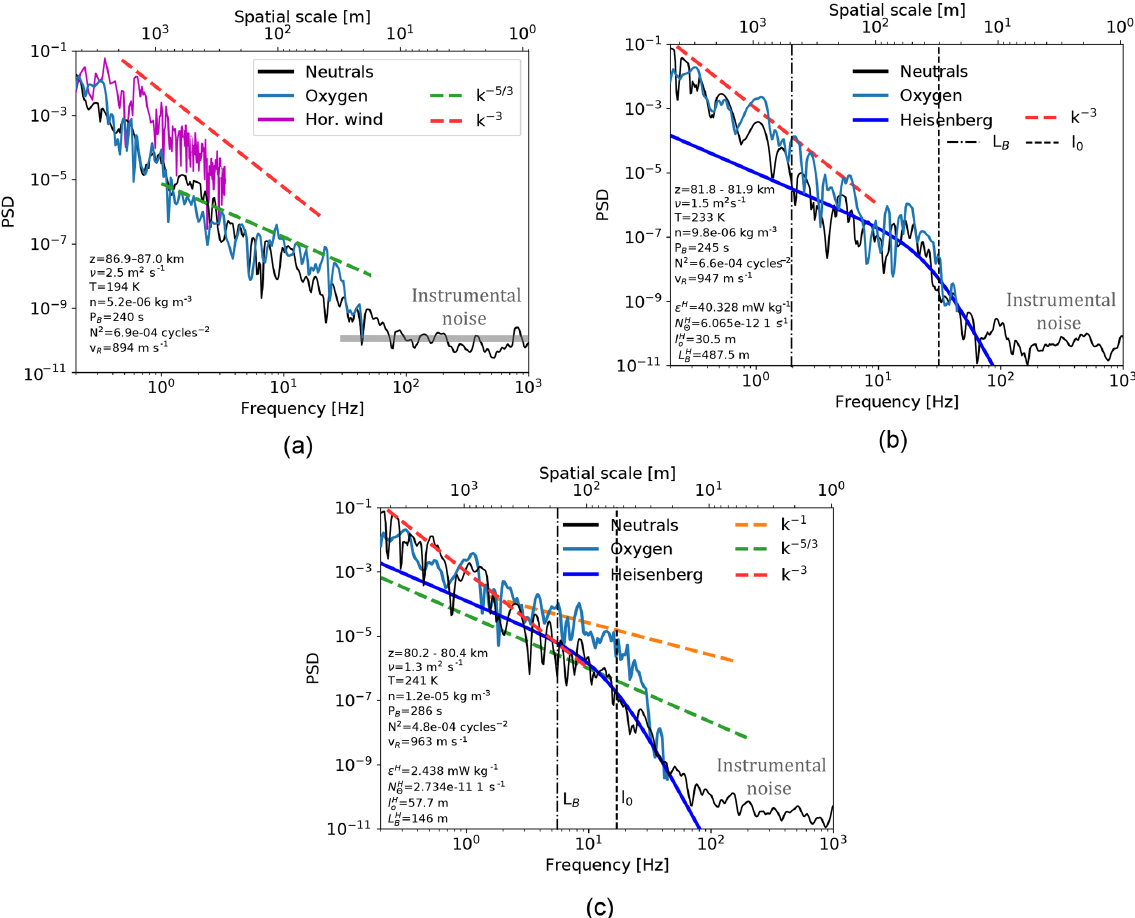
Figure 14. Normalized power spectral densities (PSDs) of horizontal wind fluctuations (magenta), density fluctuations of neutral air ( (cid:49) N n / N n ; black), and density fluctuations of atomic oxygen ( (cid:49) [O] / [O]; blue) measured during the descent of the WADIS-2 sounding rocket. Dashed red, green, and orange lines show slopes with the k − 3 , k − 5 / 3 , and k − 1 power law, respectively. Vertical black dashed and dashed-dotted lines mark the inner and buoyancy scales of turbulence, l ◦ and L B , respectively. Bold gray horizontal lines mark instrumental noise. (a) All spectra reveal a k − 3 slope attributed to gravity waves; (b) all spectra reveal both waves and turbulence. The neutral and O spectra are nearly identical. (c) The small-scale part of the O spectrum reveals a k − 1